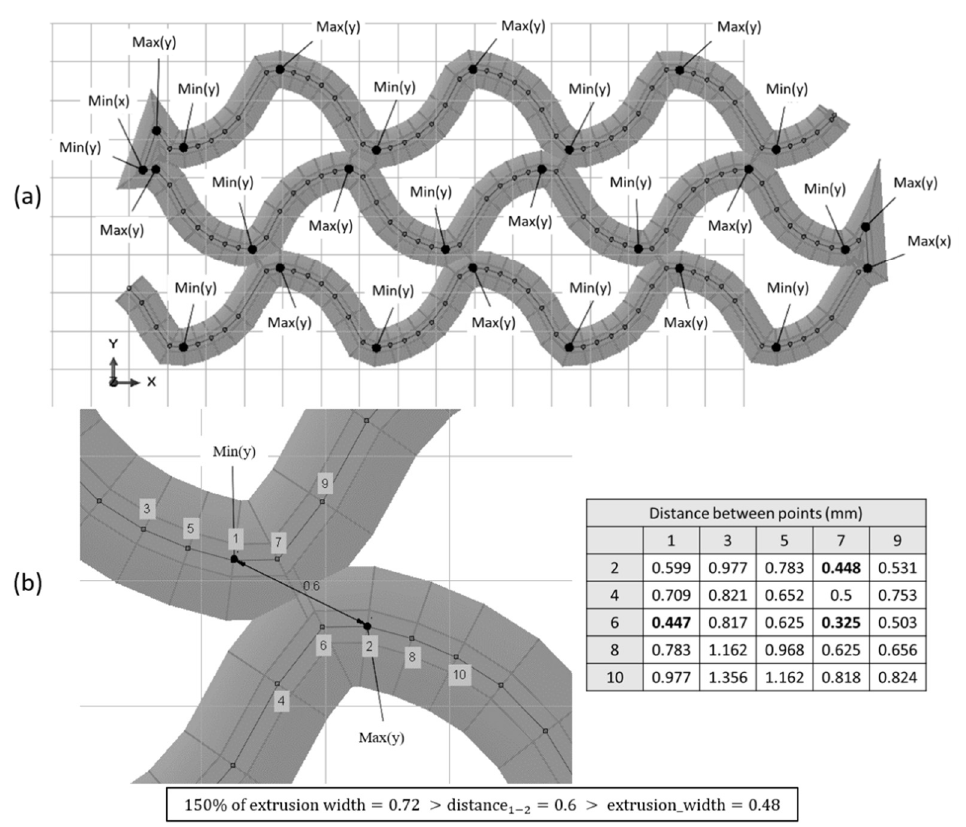
Figure 8. Peak identification in a complex geometry ( a ) and distance comparison of peaks and their previous and following points ( b ).